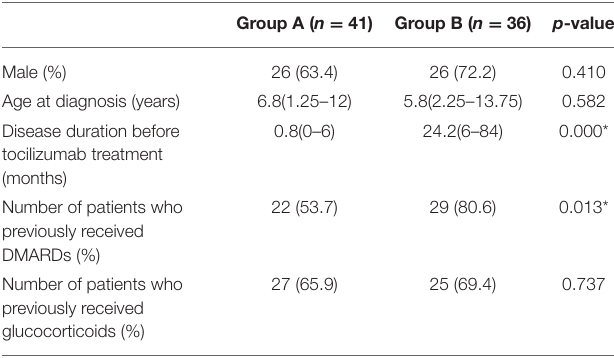
TABLE 1 | Baseline characteristics of patients with systemic juvenile idiopathic